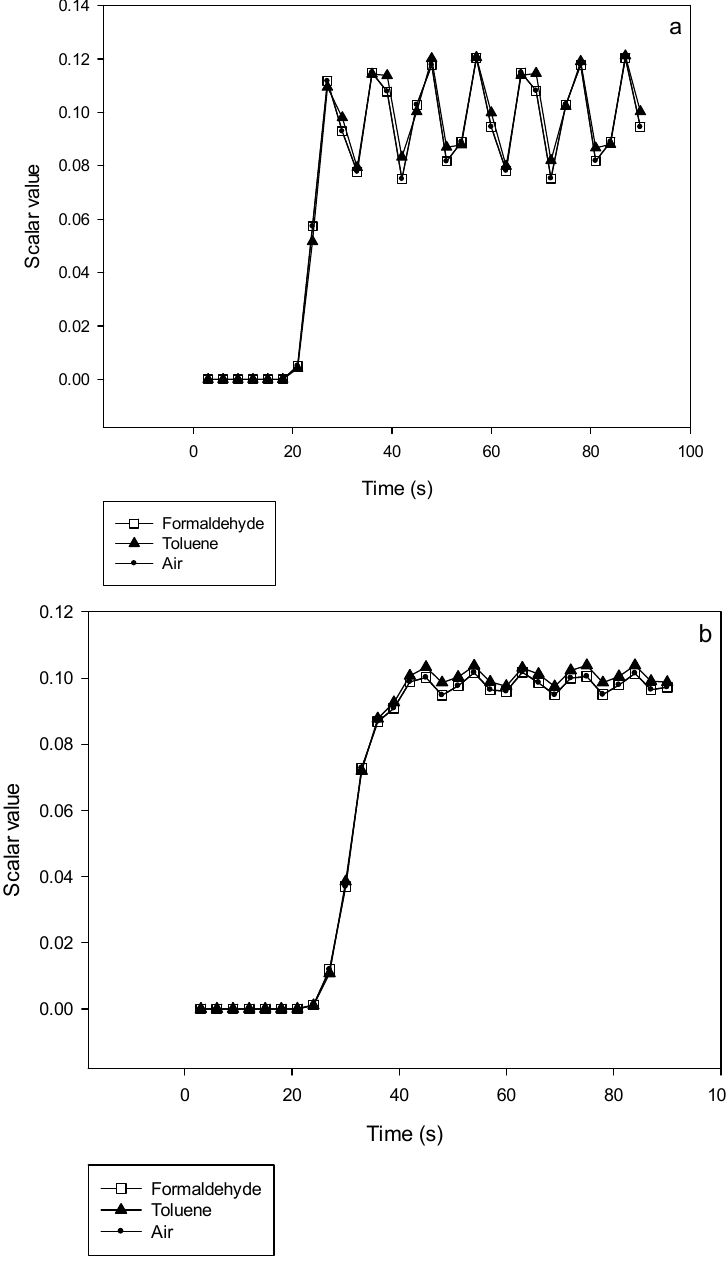
Figure 8. Comparison of the mixing’s efficiency between formaldehyde, toluene and air being mixed with pure air at 25 NmL·min − 1 . Variations of the scalar value with time at the exit of a 2-stages ( a ) or 4-stages ( b ) device, illustrating that there is almost no time response difference between formaldehyde, toluene and air.